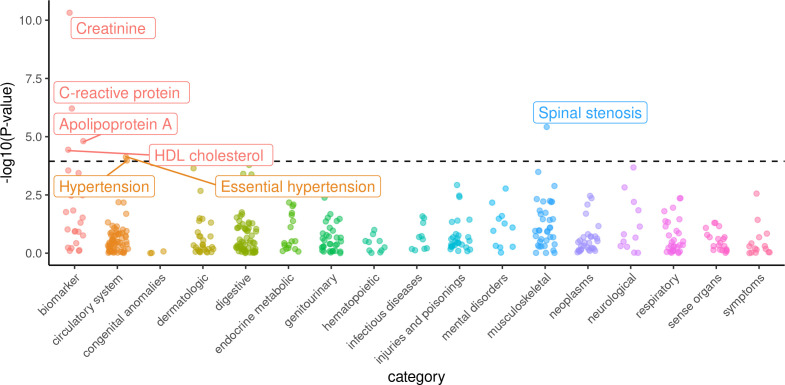
Phenome-wide survey of effects of genetically-predicted calculated free testosterone on 439 health outcomes in males from the UK Biobank.Logistic or linear regression was used to assess the association of the genetic score for free testosterone against each dichotomous or quantitative outcome, respectively. -log10(p-values) for the association of each outcome on the y-axis are stratified into subcategories on the x-axis. Labelled outcomes were statistically significant adjusting for multiple hypothesis testing (p<1.14×10−4).Figure 2—source data 1.Associations of genetically-predicted calculated free testosterone for 439 health outcomes across the human phenome.